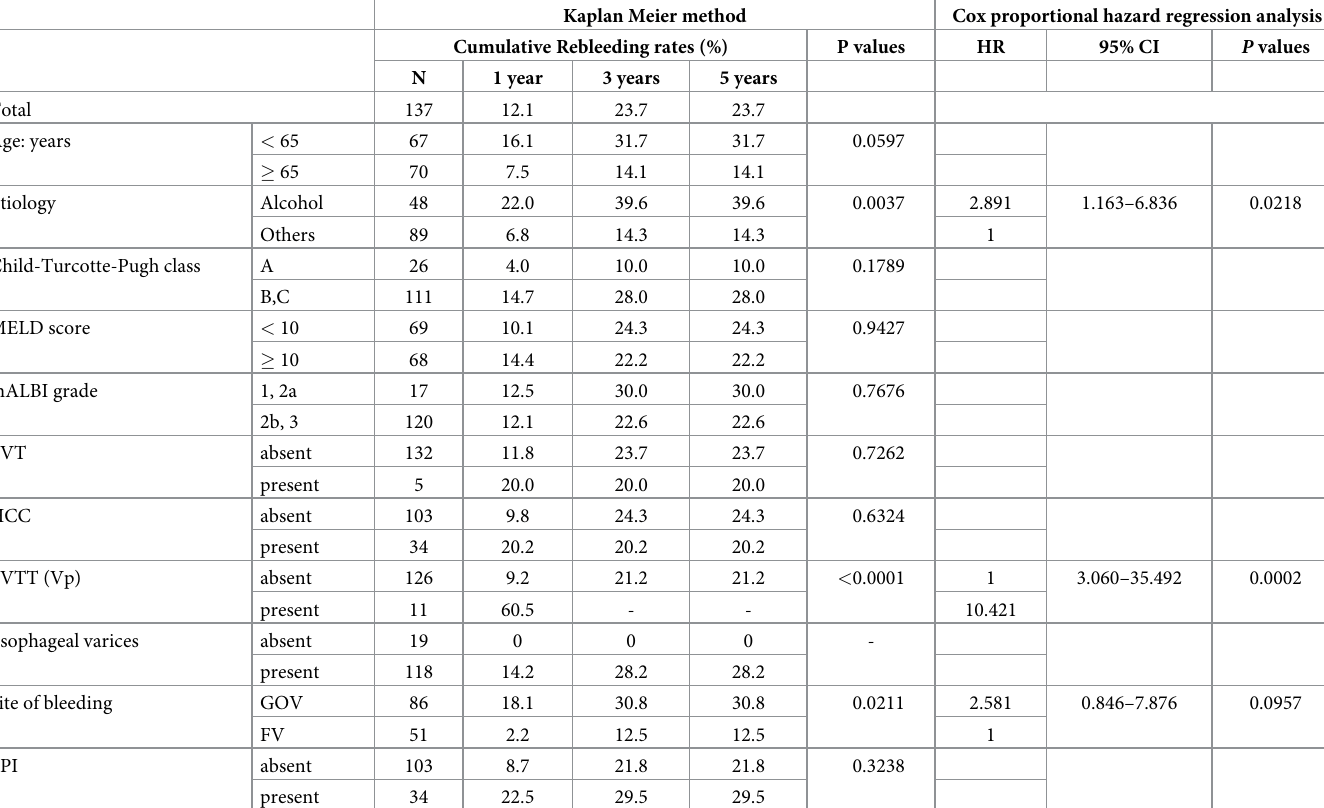
Table 2. Cumulative rebleeding rates of the 137 enrolled patients with gastric variceal bleeding and the risk factors for rebleeding.